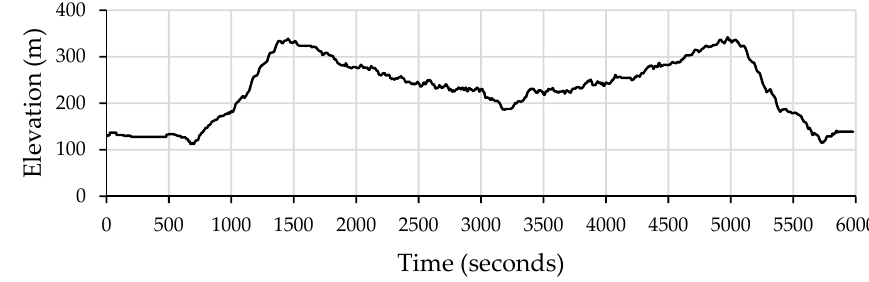
Figure 5. 80 km monitoring cycle—elevation—from Midlothian to Galashiels.